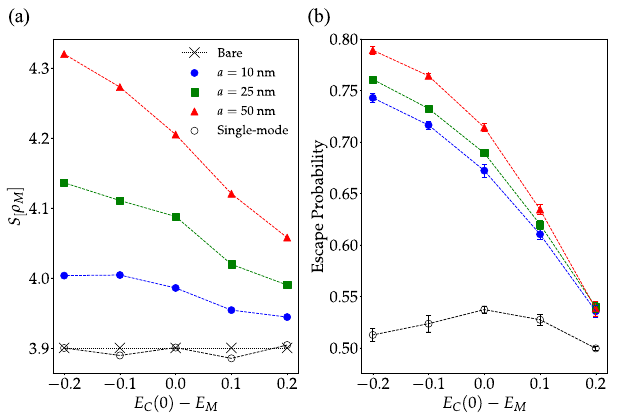
Fig. 6 Detuning effect on entropy gained by molecular LDOS and escape probability of molecular excited-states. a Entropy of molecular local density of states as a function of cavity detuning for systems with varying particle densities (but an equal number of molecules N M = 1001) and σ / Ω = 0.2 (other parameters are as in prior fi gures). The dashed line R corresponds to the entropy of the bare LDOS. b Escape probability ( χ M = 1 − Π M ) for molecular excitons as a function of cavity detuning for the same model systems. Note the escape probability vanishes for bare molecular states. Each point corresponds to the average over 10 disorder realizations (error bars indicate standard deviation).